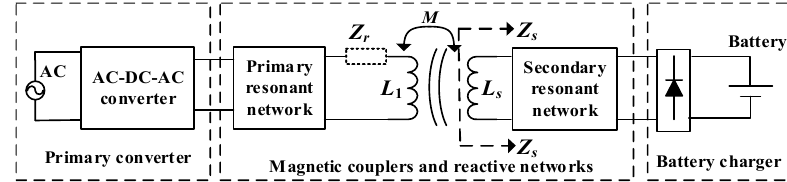
Figure 1. Typical structure of the wireless power transfer (WPT) system.